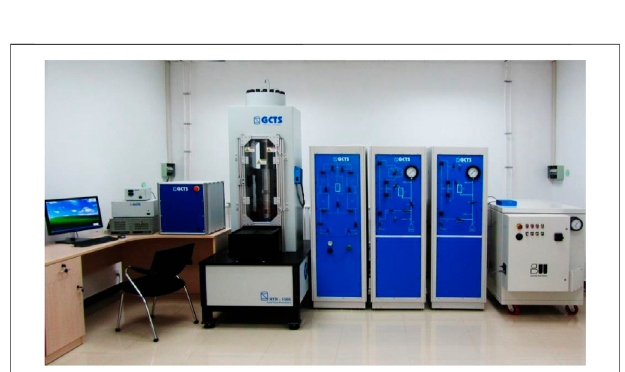
FIGURE 2 | Rapid triaxial testing system (China University of Petroleum 2021).